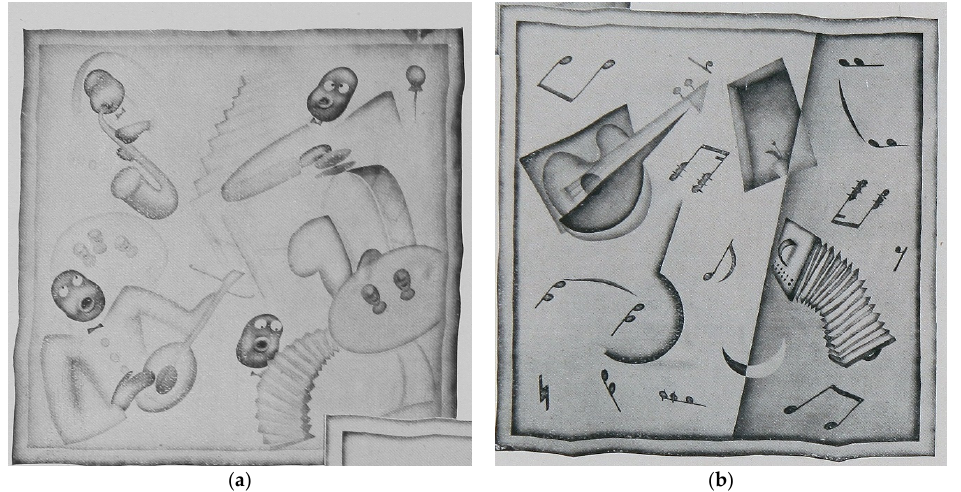
Figure 7. Fides Testi, ( a ) Jazz Band and ( b ) Serenata , silks decorated with airbrush. Photos from (Albano 1929). In public domain.